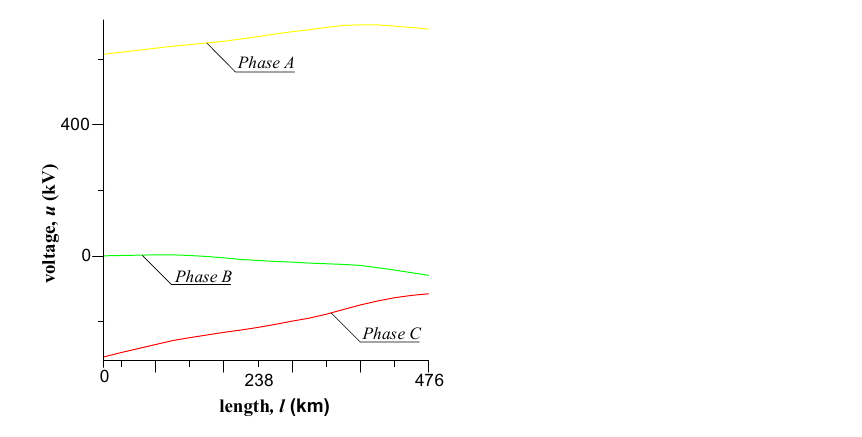
We can see that at t = 0.005 s, the phase A voltage at the line’s beginning is 600 kV, rising gradually along the line until reaching 640 kV. The phase B voltage at the line’s beginning is zero and rises gradually along the line until reaching −40 kV due to the